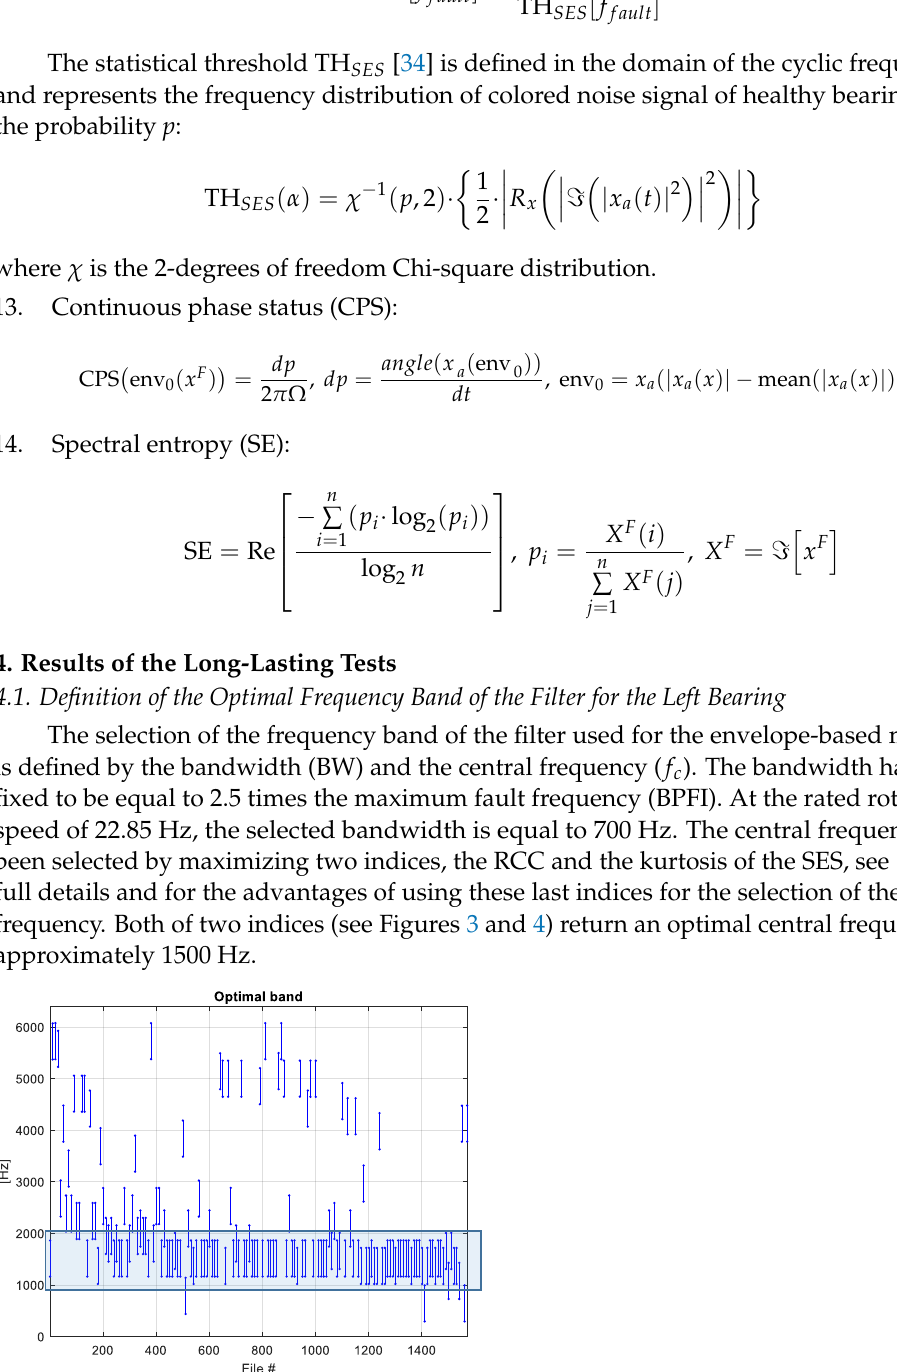
Figure 3. Definition of the optimal frequency band for filtering the residual signal according to the RCC index—left TB.